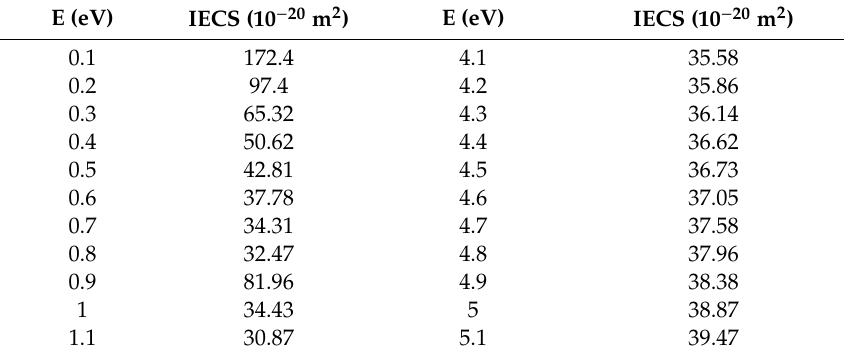
0.1 Figure 5. Complete set of integral electron scattering cross sections for modelling electron transport Figure 5. Complete set of integral electron scattering cross sections for modelling electron transport Figure 5. Complete set of integral electron scattering cross sections for modelling electron transport Figure 5. Complete set of integral electron scattering cross sections for modelling electron transport Figure 5. Complete set of integral electron scattering cross sections for modelling electron transport Figure 5. Complete set of integral electron scattering cross sections for modelling electron transport Figure 5. Complete set of integral electron scattering cross sections for modelling electron transport Figure 5. Complete set of integral electron scattering cross sections for modelling electron transport Figure 5. Complete set of integral electron scattering cross sections for modelling electron transport in pyridine in the energy range (0–100 eV): , experimental data [3] including electrons elastically in pyridine in the energy range (0–100 eV): , experimental data [3] including electrons elastically in pyridine in the energy range (0–100 eV): , experimental data [3] including electrons elastically in pyridine in the energy range (0–100 eV): , experimental data [3] including electrons elastically in pyridine in the energy range (0–100 eV): , experimental data [3] including electrons elastically in pyridine in the energy range (0–100 eV): , experimental data [3] including electrons elastically in pyridine in the energy range (0–100 eV): , experimental data [3] including electrons elastically in pyridine in the energy range (0–100 eV): , experimental data [3] including electrons elastically in pyridine in the energy range (0–100 eV): , experimental data [3] including electrons elastically scattered into the “missing” angles (see text for details); , IECS based on the present R-matrix scattered into the “missing” angles (see text for details); , IECS based on the present R-matrix scattered into the “missing” angles (see text for details); , IECS based on the present R-matrix scattered into the “missing” angles (see text for details); , IECS based on the present R-matrix scattered into the “missing” angles (see text for details); , IECS based on the present R-matrix scattered into the “missing” angles (see text for details); , IECS based on the present R-matrix scattered into the “missing” angles (see text for details); , IECS based on the present R-matrix scattered into the “missing” angles (see text for details); , IECS based on the present R-matrix scattered into the “missing” angles (see text for details); , IECS based on the present R-matrix and and IAM-SCAR calculations; , ionization; , electronic excitation; , vibrational and IAM-SCAR calculations; , ionization; , electronic excitation; , vibrational and IAM-SCAR calculations; , ionization; , electronic excitation; , vibrational and IAM-SCAR calculations; , ionization; , electronic excitation; , vibrational and IAM-SCAR calculations; and IAM-SCAR calculations; , ionization; , electronic excitation; , vibrational and IAM-SCAR calculations; , ionization; , electronic excitation; , vibrational and IAM-SCAR calculations; , ionization; , electronic excitation; , vibrational IAM-SCAR calculations; , ionization; , vibrational excitation; excitation; , electron attachment; , dipole-Born rotational excitation. excitation; , electron attachment; , dipole-Born rotational excitation. excitation; , electron attachment; , dipole-Born rotational excitation. excitation; , dipole-Born rotational excitation. excitation; , electron attachment; , dipole-Born rotational excitation. excitation; , electron attachment; , dipole-Born rotational excitation. excitation; , electron attachment; , dipole-Born rotational excitation. Table 2. Integral elastic electron scattering cross sections for pyridine in the energy range 0.1–20 eV, in SI units (10 − 20 m 2 ), as calculated with the SMC method (see text for